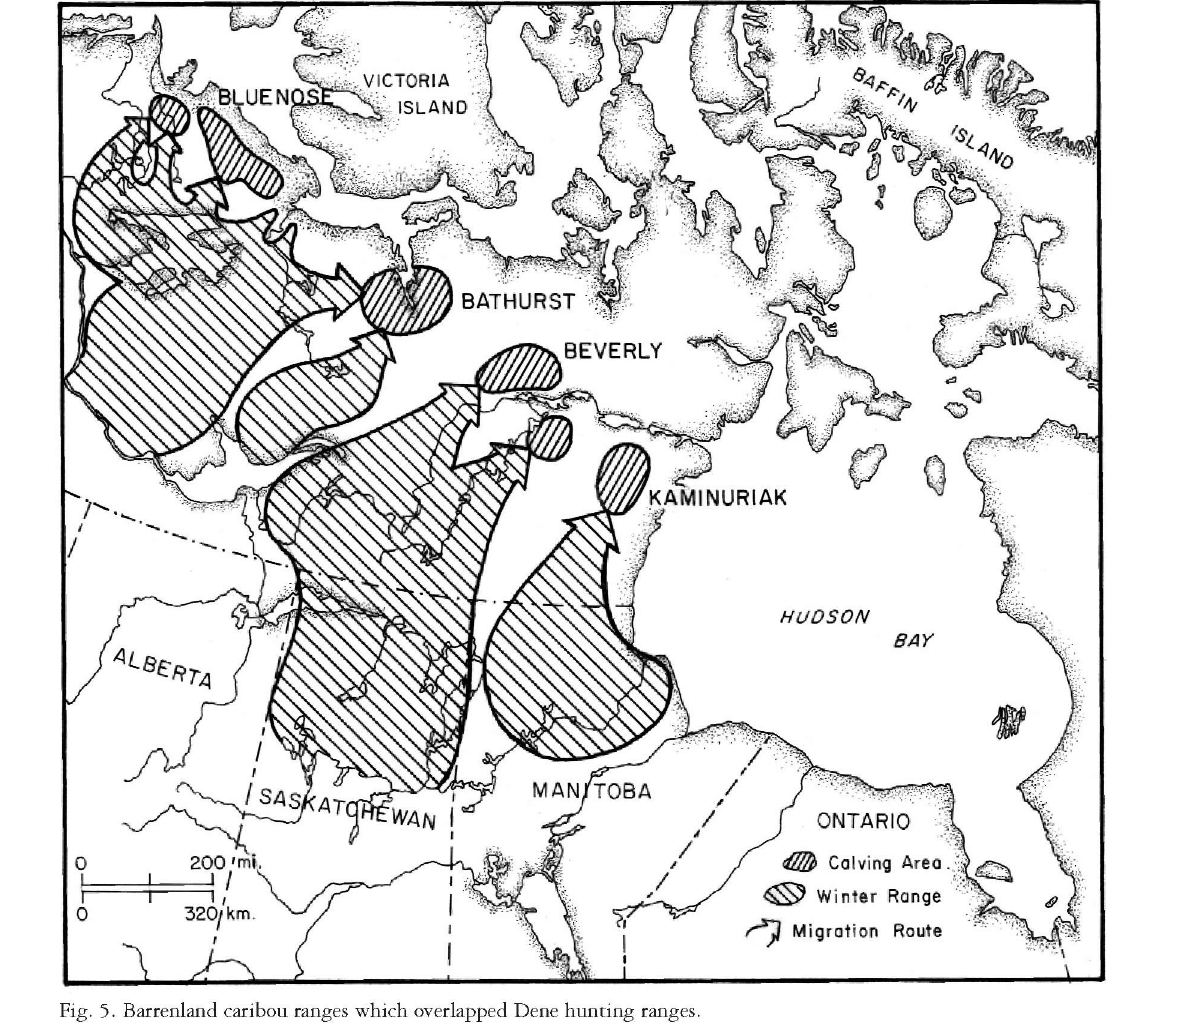
Fig. 5. Barrenland caribou ranges which overlapped Dene hunting ranges. The tremendous influence migratory game has on hunters is apparent in Dene caribou